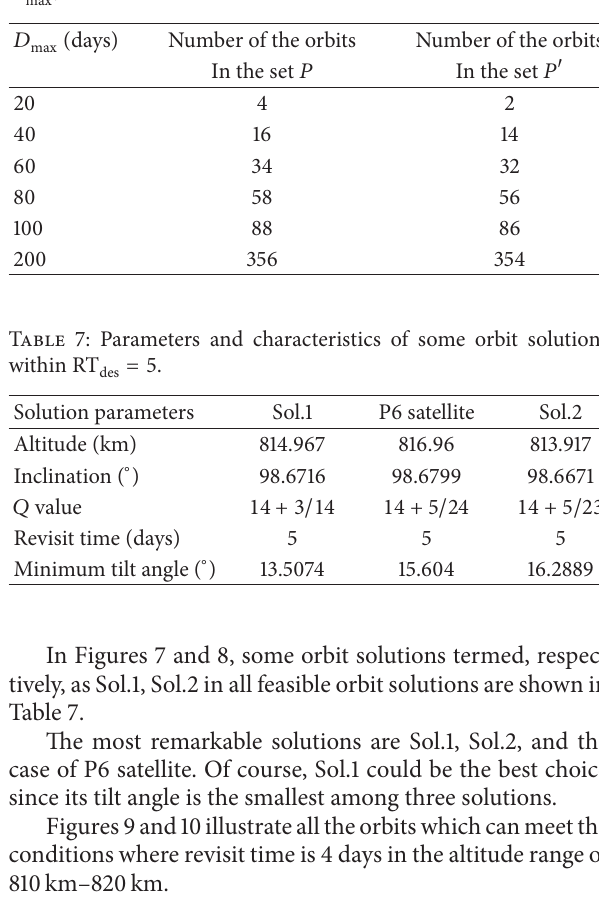
Table 6: The number of the orbits in sets 𝑃 and 𝑃 󸀠 with different 𝐷 max .